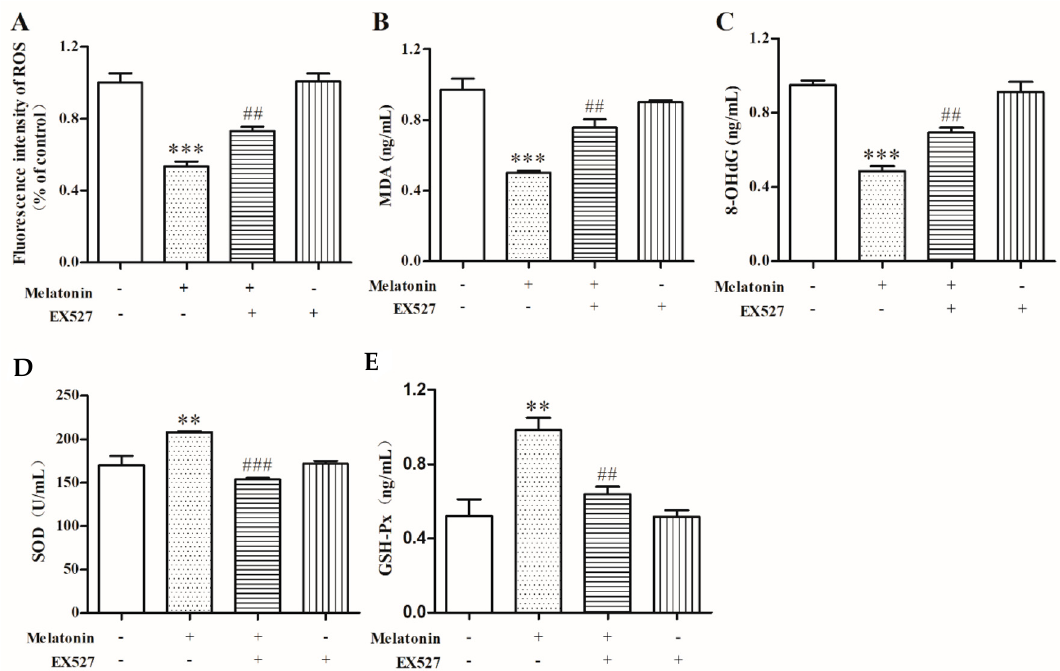
Figure 6. E ff ects of melatonin and EX527 on ROS, MDA, 8-OHdG, SOD, and GSH-Px in mouse Leydig cells. ( A ) The fluorescence intensity of ROS was measured by flow cytometry analysis ( n = 3). The levels of MDA ( B ), 8-OHdG ( C ), SOD ( D ), and GSH-Px ( E ) were measured by a microplate reader ( n = 3). Values are shown as mean ± SEM. *** p < 0.001 or ** p < 0.01 compared with the control group; ### p < 0.001 or ## p < 0.01 compared with melatonin-only treatment